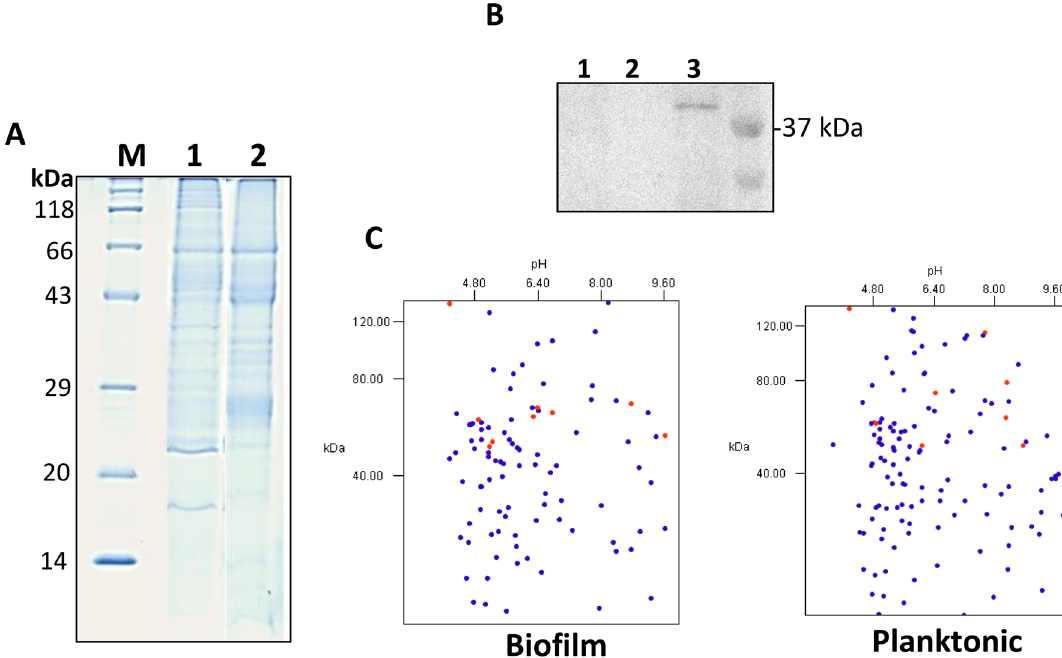
Figure 1. Analysis of the proteome of P. intermedia biofilm and planktonic cells. ( A ) SDS–PAGE gel showing protein bands from protein preparations: biofilm (lane 1) and planktonic cells (lane 2). ( B ) Western blot analysis of the secretome preparations (lane 1 = biofilm, lane 2 = planktonic) and the WCP (lane 3) using an antibody for the cytoplasmic marker protein FtsZ. ( C ) Protein sequences from LC–MS analysis of the secretome were analyzed by an in silico 2DE